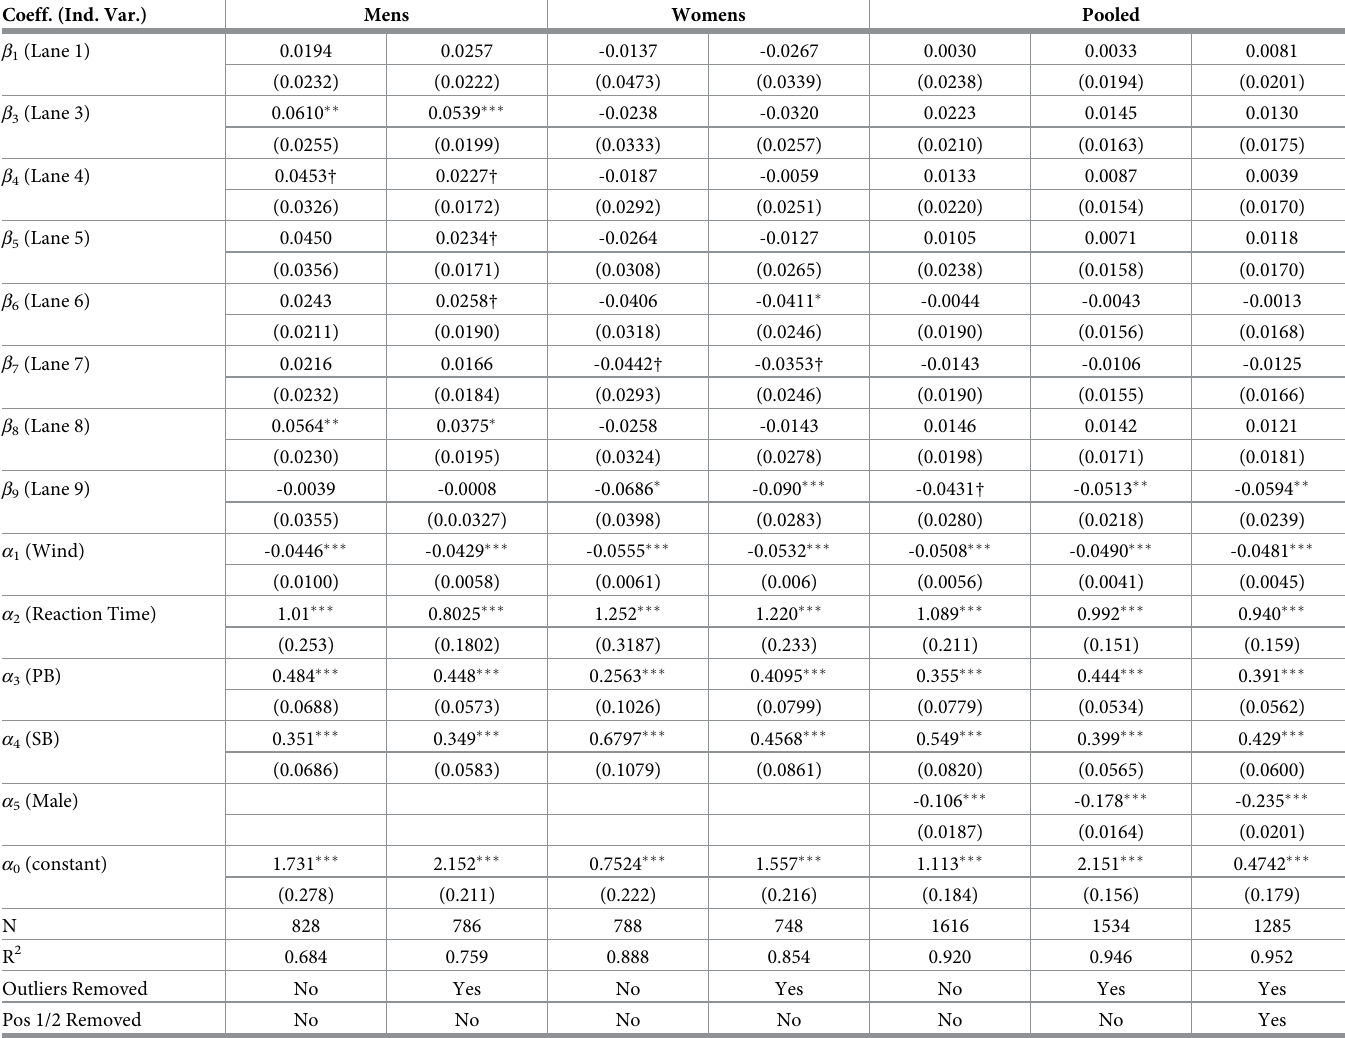
Table 2. Regression results for 100m. Coeff. (Ind.